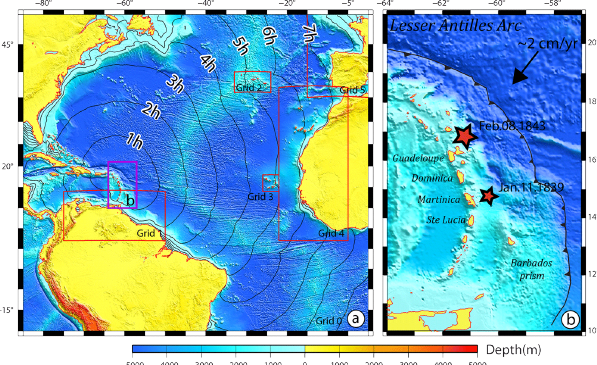
Figure 1. (a) Travel times of a tsunami (TTT) triggered by an earth- quake occuring at the Lesser Antilles subduction interface and trav- elling across the Northern Atlantic Ocean. Shadded bathymetry has been added to underline the role played by submarine features over tsunami propagation. The geographical boundaries of the calcula- tion grids are located. (b) General tectonic setings of the Lesser An- tilles Arc: the solid black line with triangles locates the accretion- nary prism frontal thrust (Feuillet et al., 2011a). Both megathrust earthquake estimated epicenters from 8 February 1843 ( M w ∼ 8 . 0– 8.5) and 11 January 1839 ( M w ∼ 7 . 5–8.0) are symbolized by red stars. The compression rate and direction indicated by a black ar- row is from DeMets et al.